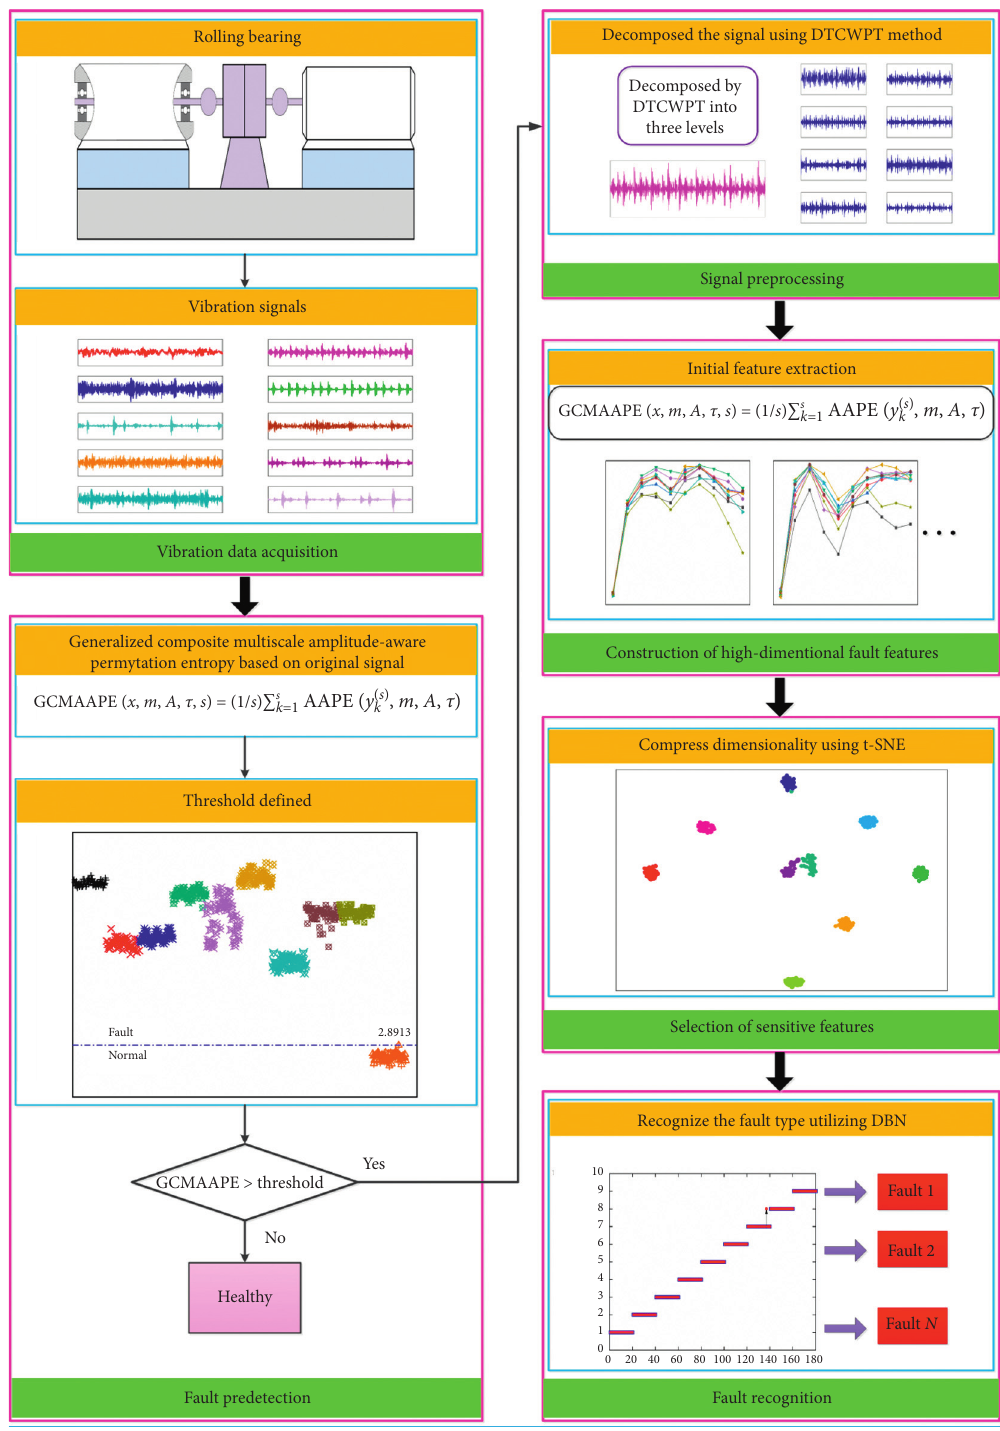
Figure 7: The technical route of the presented